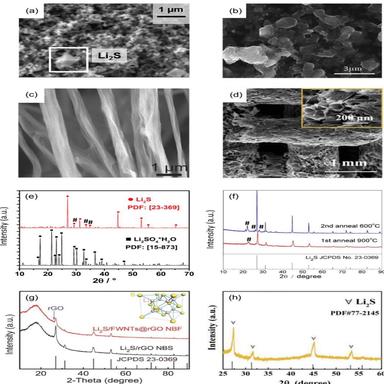
The SEM images (a–d) and XRD patterns (e–h) of several Li2S-C cathode materials. The SEM images of (a) Li2S-C by ball-milling pre-treatments , (b) Li2S-C by carbon coating, (c) Li2S/FWNTs@rGO NBF by template synthesis , and (d) Li2S-C via 3D printing. The XRD patterns of (e) the synthesized Li2S and the precursor Li2SO4-H2O, (f) the Li2S-C during the two annealing processes, (g) the synthesized Li2S/rGO NBS and Li2S/FWNTs@rGO